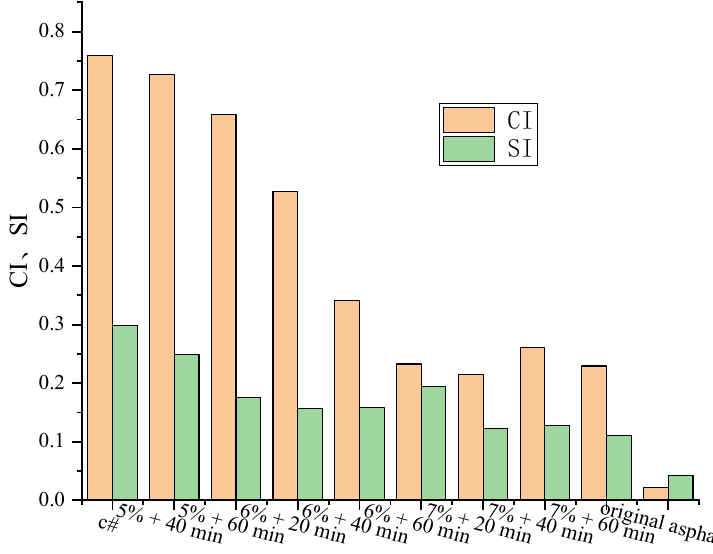
Figure 4. CI and SI values of aging asphalt after regeneration-moistening.